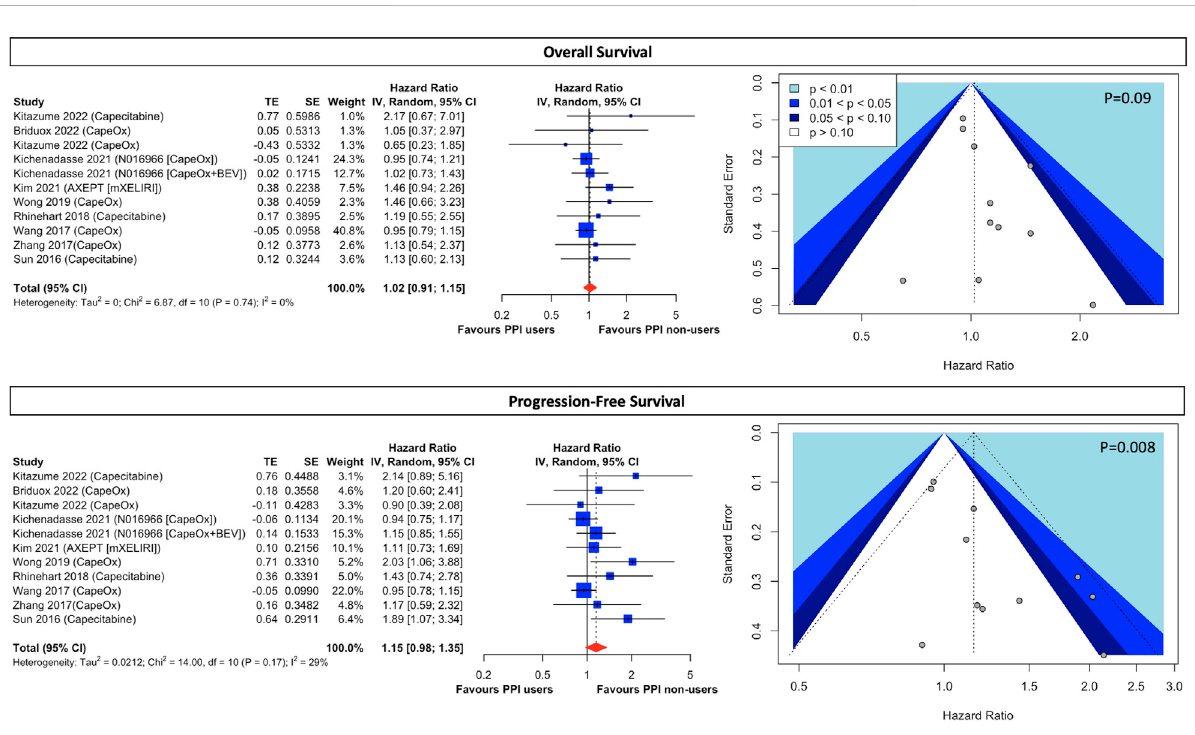
FIGURE 2 Forest plot and funnel plot of comparative overall survival and progression-free survival between PPI users and non-users in CRC cancer patients treated with capecitabine-based regimens The size of squares is proportional to the weight of each study. Horizontal lines indicate the 95% CI of each study; diamond, the pooled estimate with 95%. PPI, proton pump inhibitors; CI, con fi dential interval; CRC, colorectal cancers; CapeOx, capecitabine plus oxaliplatin; mXELIRI, capecitabine plus irinotecan; BEV,